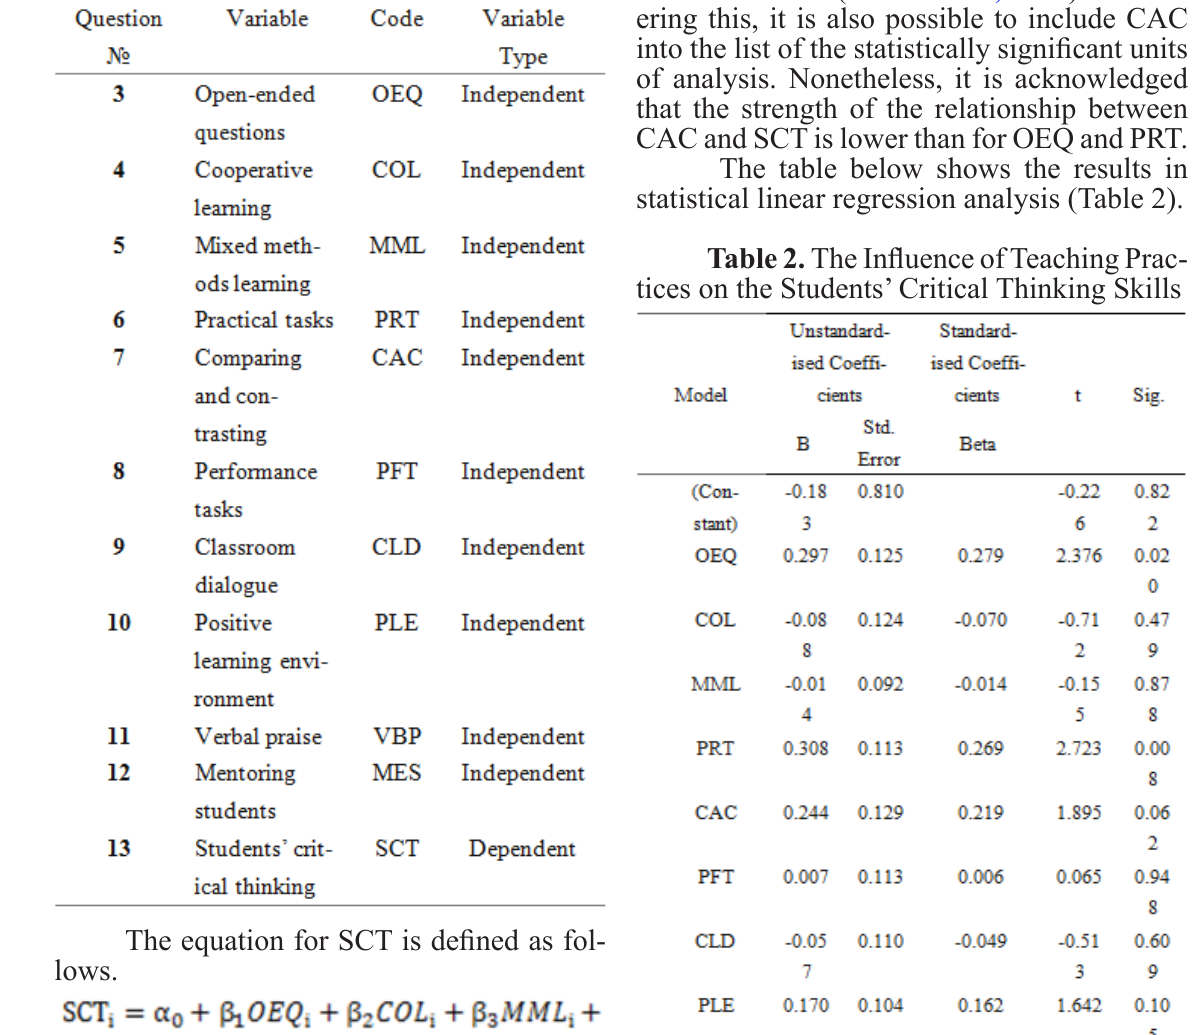
Table 1. Variable Definition